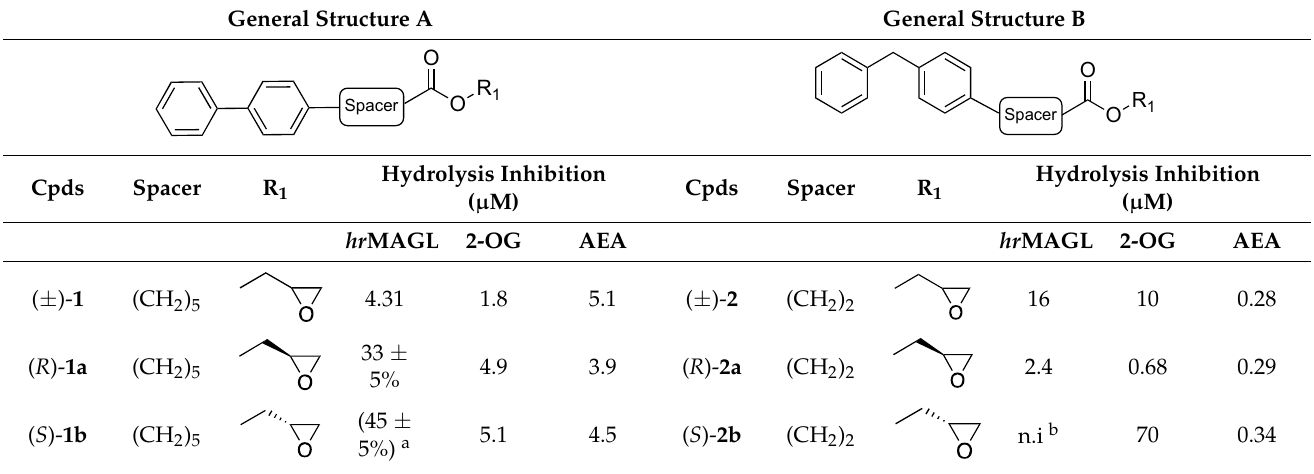
Table 1. Activity of racemic compounds ( ± )- 1 and ( ± )- 2 and their respective enantiomers against hr MAGL and 2-OG and AEA hydrolysis inhibition.